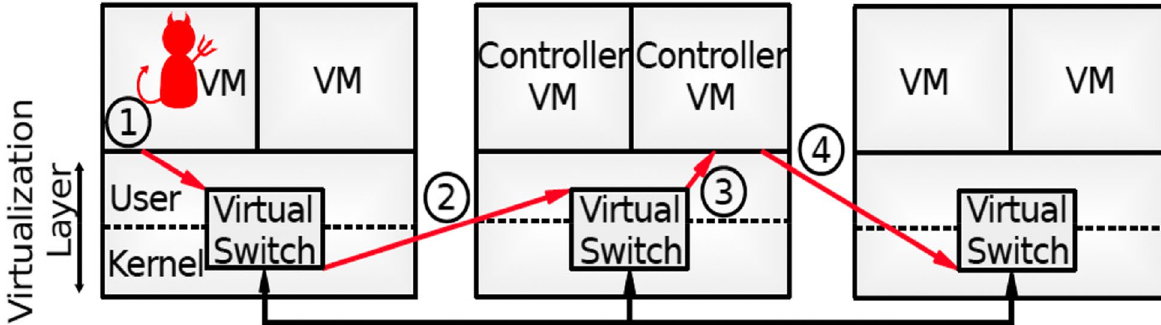
Fig. 4 Overview of Security